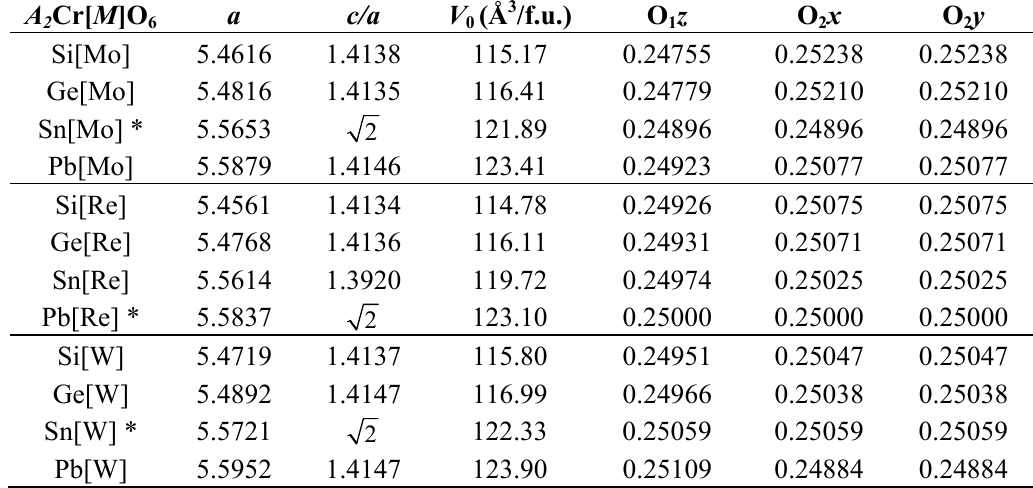
Table 2. Structural parameters in the fully optimized structure ( , no. 139